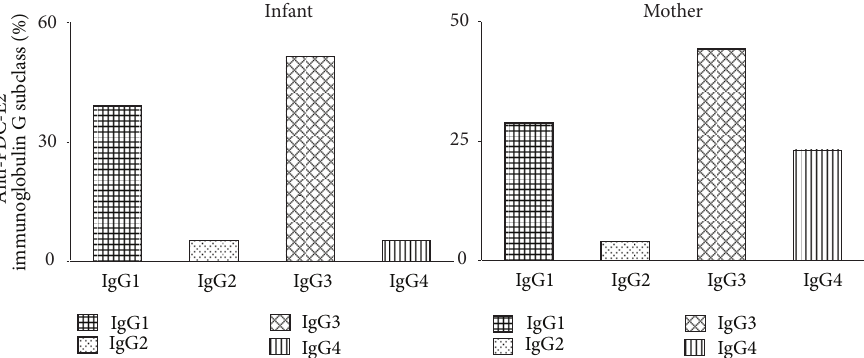
cirrhosis. Antibody reactivity to the E2 subunits of branched chain oxoacid dehydrogenase complex (BCOADC-E2)andoxoaciddehydrogenasecomplex(OGDC-E2),whicharealsoimmunodominantantigens, is not detectable. The dashed line represents the cut-off of 0.24 (mean average+5 standard deviations) of 28 normal controls tested in triplicate